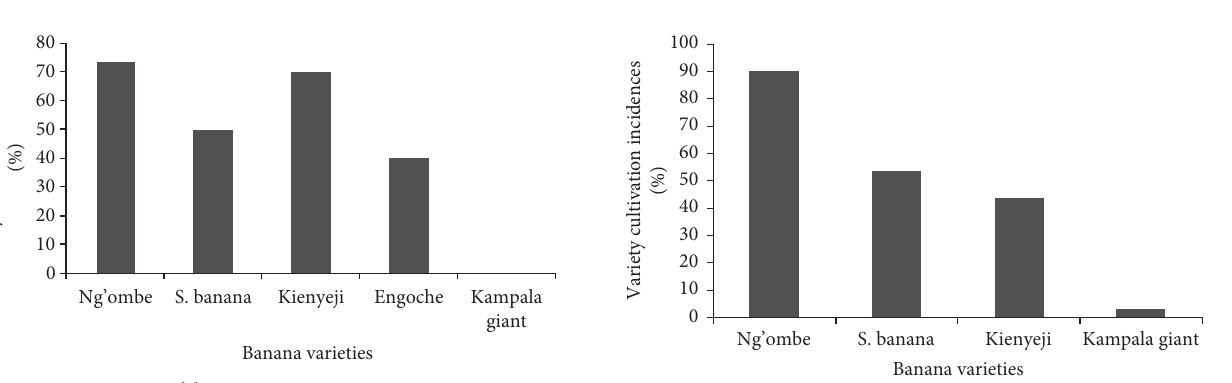
Figure 7: Local banana varieties in Kisii County.